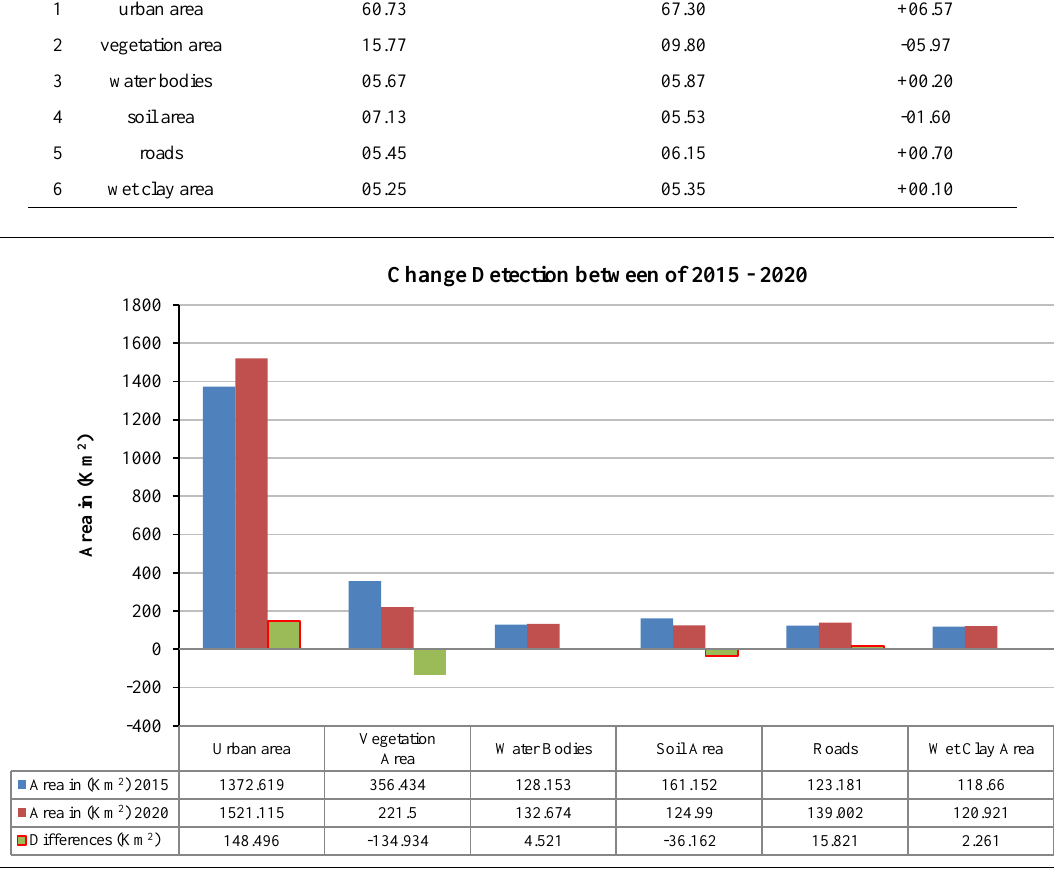
Figure 9. Change detection of each class of the study area between 2015 and